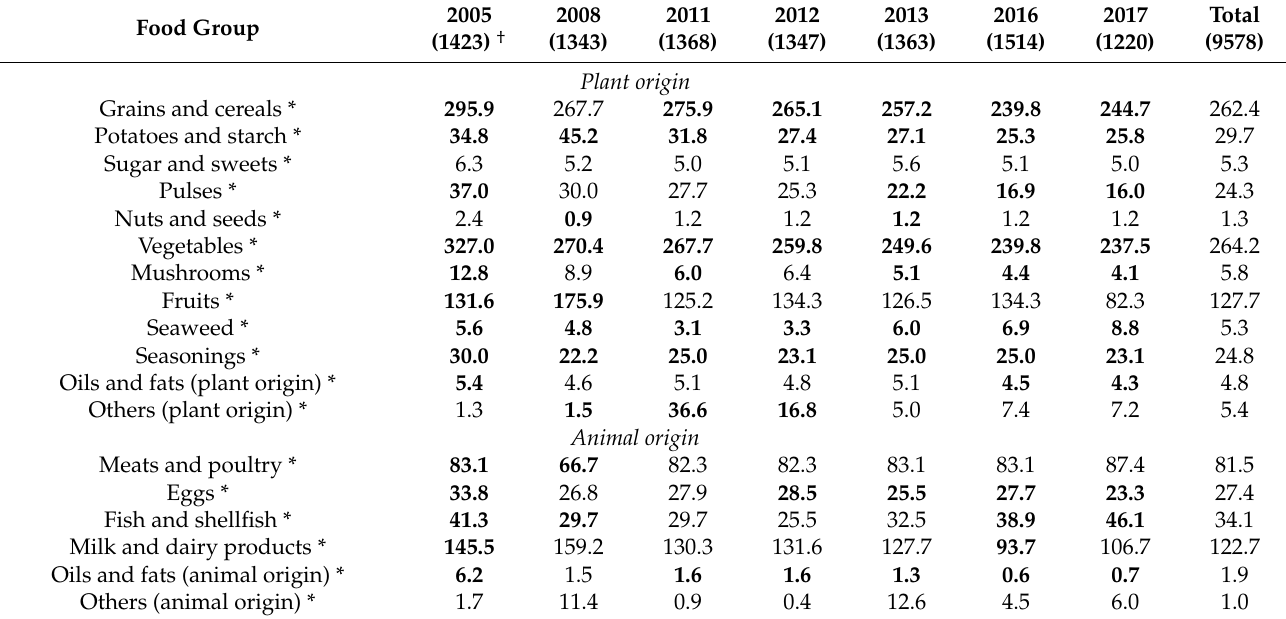
Table 1. Variation GM (g) in each food group based on a 24-h recall test from the 2005 to 2017 surveys.